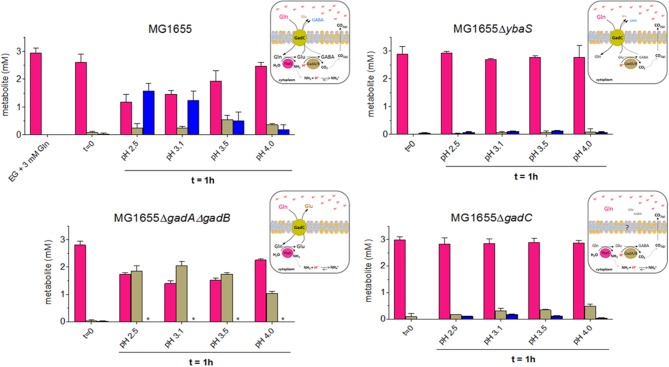
HPLC analysis of Gln, Glu and GABA levels in EG medium at different pHs and from the different mutant strains derived from wild type E. coli MG1655. Following the protocol described in Materials and Methods (Section HPLC Analysis of Glutamine, Glutamate and GABA in Spent Media), and represented graphically in Figure S4, bacteria were incubated for 1 h at 37°C. Each spent medium was analyzed by HPLC for glutamine (magenta), glutamate (light dove) and GABA (blue) content. Each panel is accompanied by a schematic representation of the cellular context that provides a possible explanation for the observed findings. *means GABA not detected.